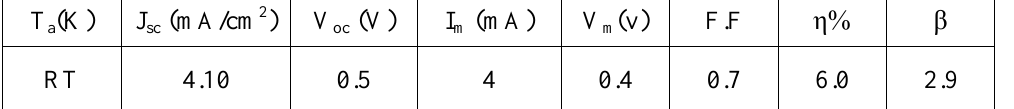
Table 7: I-V parameters for ZnO /GaAs